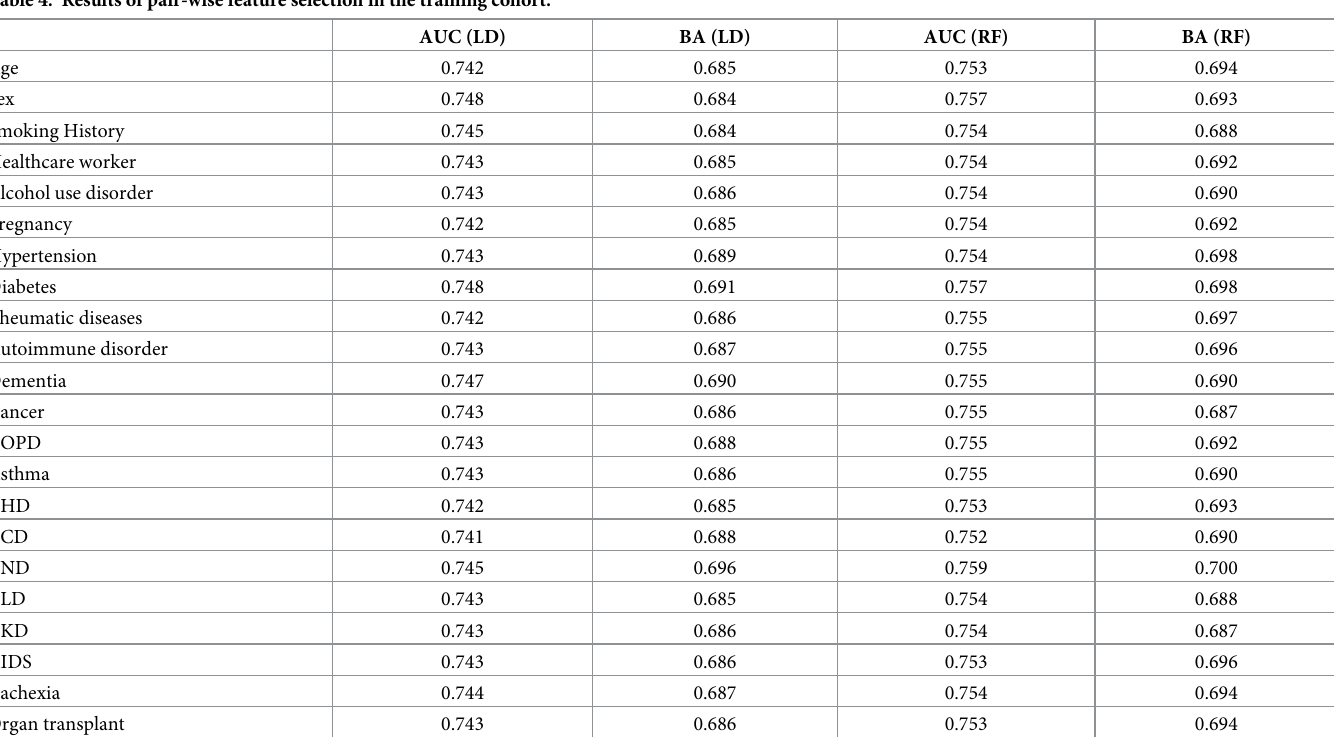
Table 4. Results of pair-wise feature selection in the training cohort.